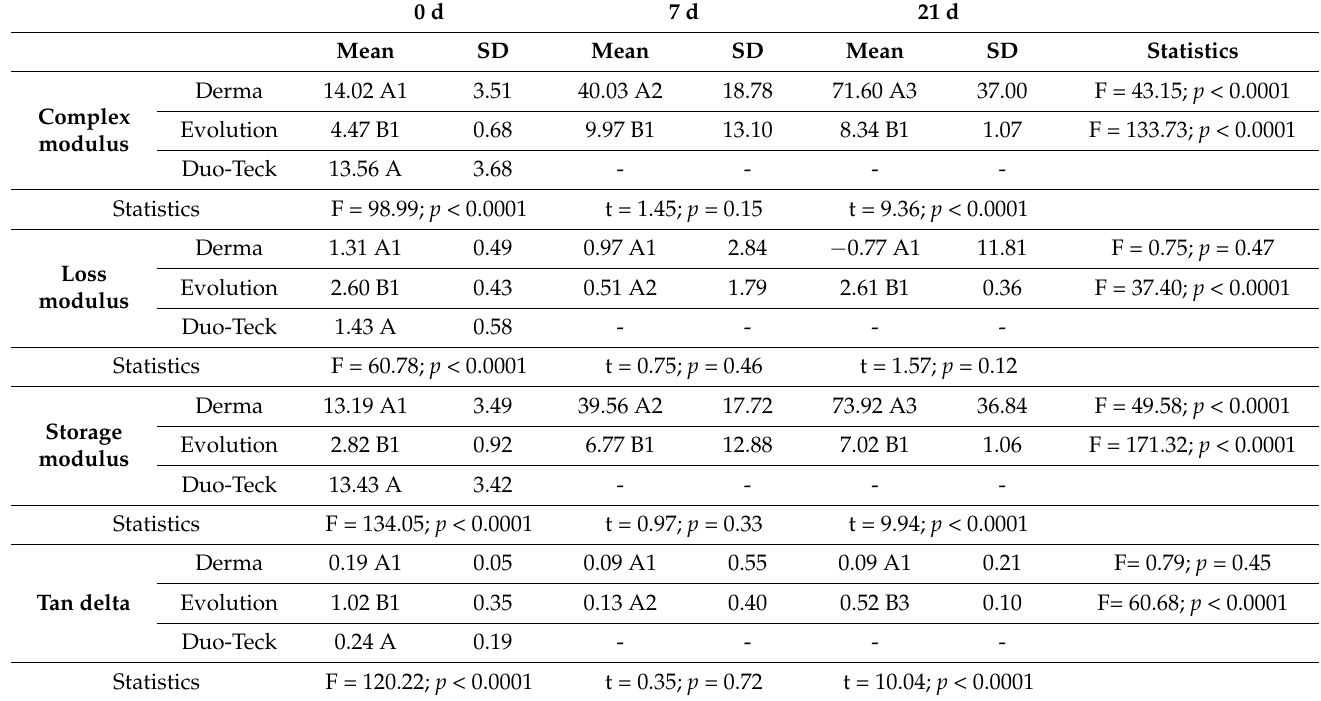
Table 2. Nanomechanical properties measured on the different membranes after the different periods of immersion (expressed as mean and standard deviations -SD-). Distinct letters indicate statistically significant differences between membranes and numbers between immersion periods ( p <